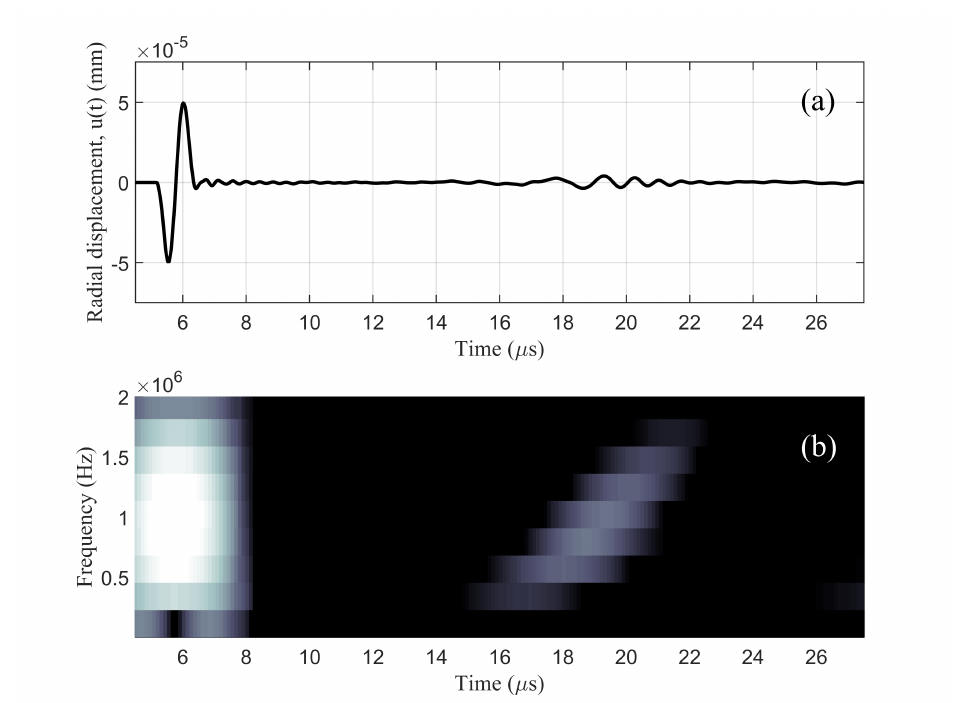
Figure 6. ( a ) Time domain radial displacement u ( t ) at transmitter T of model IM and ( b ) spectrogram obtained by applying STFT to u ( t ) .